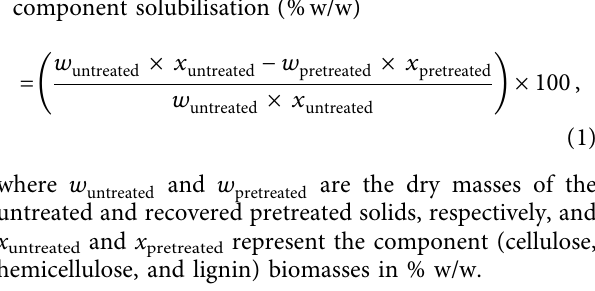
2 SO 4 , (b) 3% NaOH, (c) hot water, and (d)